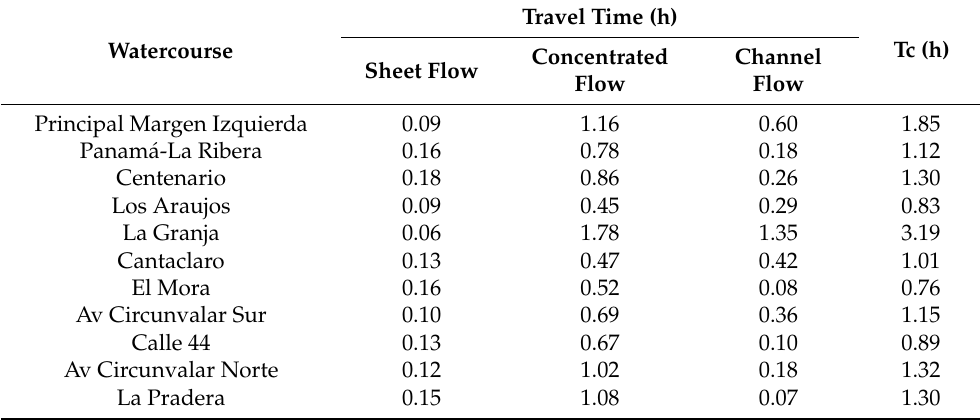
Table 3. Travel time and Tc of the baseline